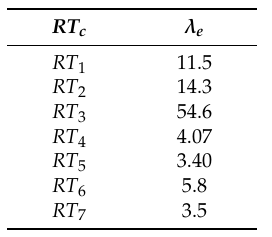
Table 9. The experts’ estimate of parameter λ e risk category.